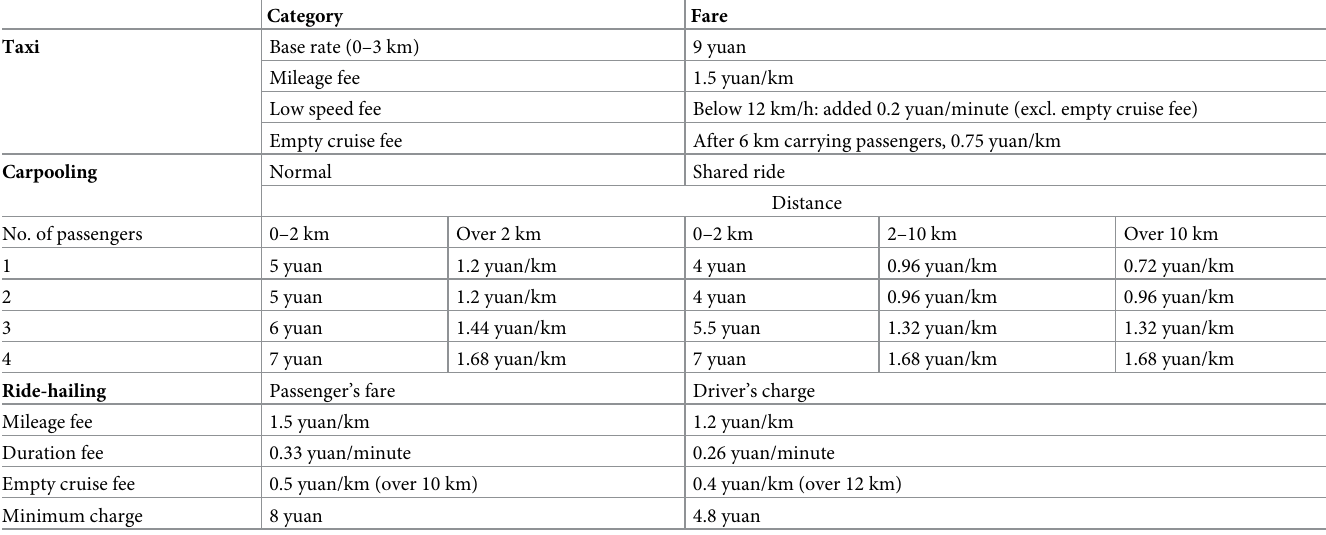
Table 3. Charge standard for taxis and ride-hailing services in Jinan.